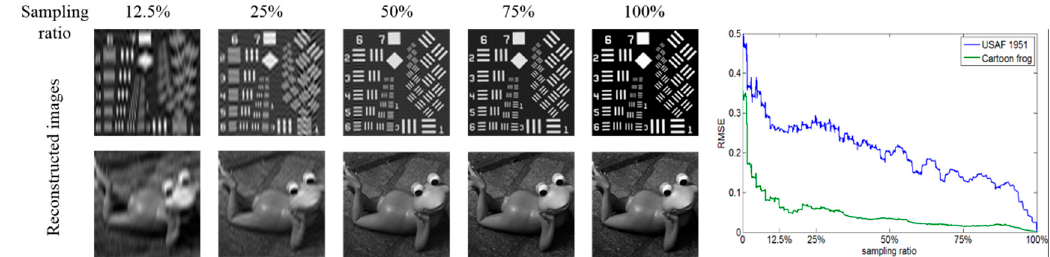
× pixels, and the full sampling ratio